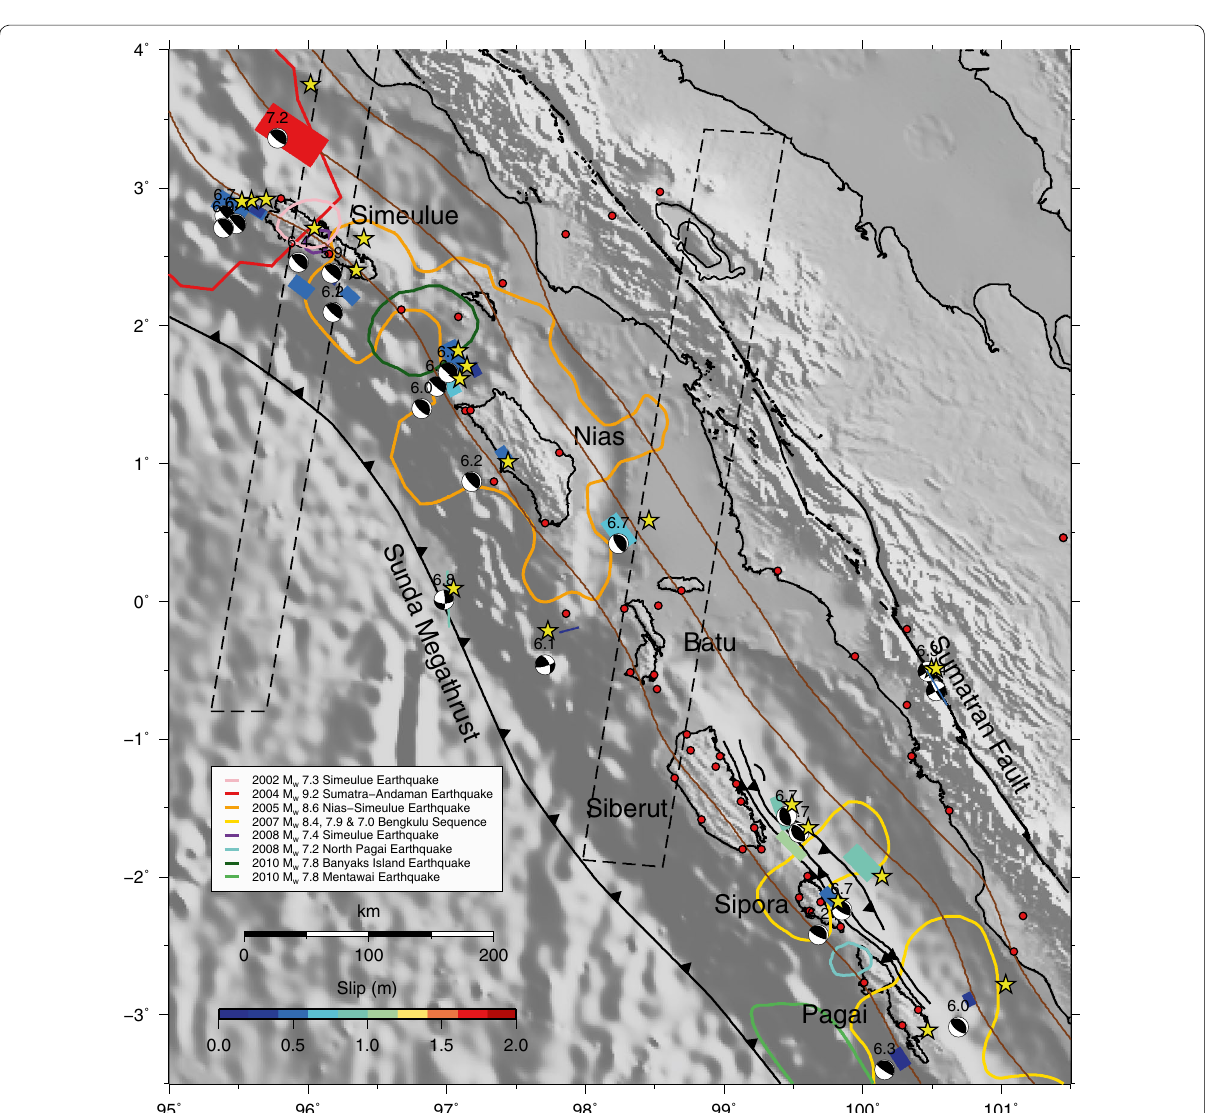
Fig. 1 Map of all the events modeled in this study. Rectangular colored patches or short lines show the final slip models for one M w 7.2 event and 20 moderate (5.9 M w < 7) events obtained from this study. Focal mechanisms are placed at the gCMT centroid locations (Dziewonski et al. ≤ 1981; Ekström et al. 2012). Yellow stars indicate the Advanced National Seismic System (ANSS) epicenters (NCEDC 2016). Solid colored lines outline published 1-m slip contours for the 2004 M w 9.2 Sumatra–Andaman earthquake (Chlieh et al. 2007), the 2005 M w 8.6 Nias–Simeulue earthquake (Konca et al. 2007), the 2007 M w 8.4 Bengkulu earthquake and its two M w 7.9 and 7.0 aftershocks (Tsang et al. 2016), the 2008 M w 7.2 North Pagai earthquake (Salman et al. 2017), the 2010 M w 7.8 Mentawai earthquake (Hill et al. 2012), the 2002 M w 7.3 and 2008 M w 7.4 Simeulue sibling earthquakes (Morgan et al. 2017), and the 2010 M w 7.8 Banyaks Island earthquake (Morgan et al. 2015). Red circles are the SuGAr stations (Feng et al. 2015). Black dashed boxes delineate the inferred subducted fracture zones underneath Simeulue (Franke et al. 2008) and the Batu Islands (Pesicek et al. 2010) based on seismicity. Brown lines are slab contours at 20 km, 40 km, and 60 km intervals from Slab1.0 (Hayes et al.